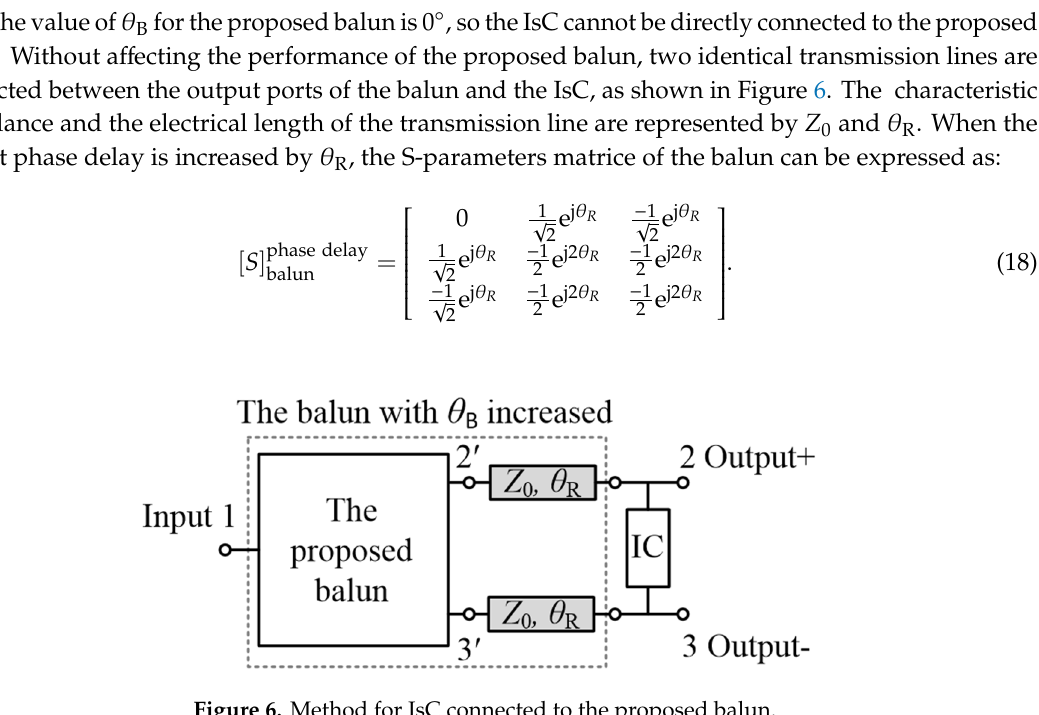
Figure 6. Method for IsC connected to the proposed